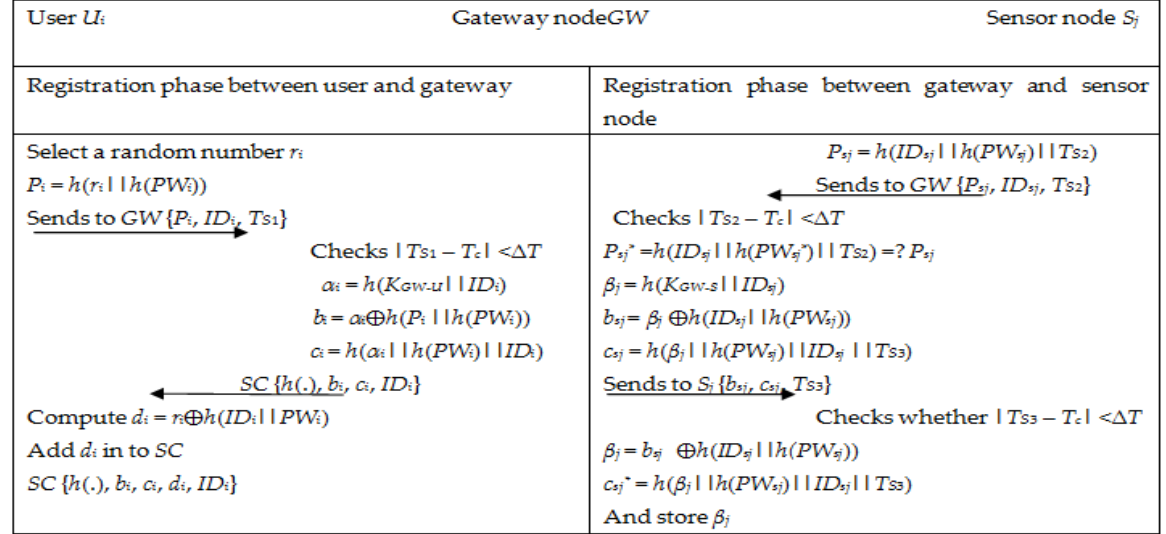
Figure 1. Notations and description.